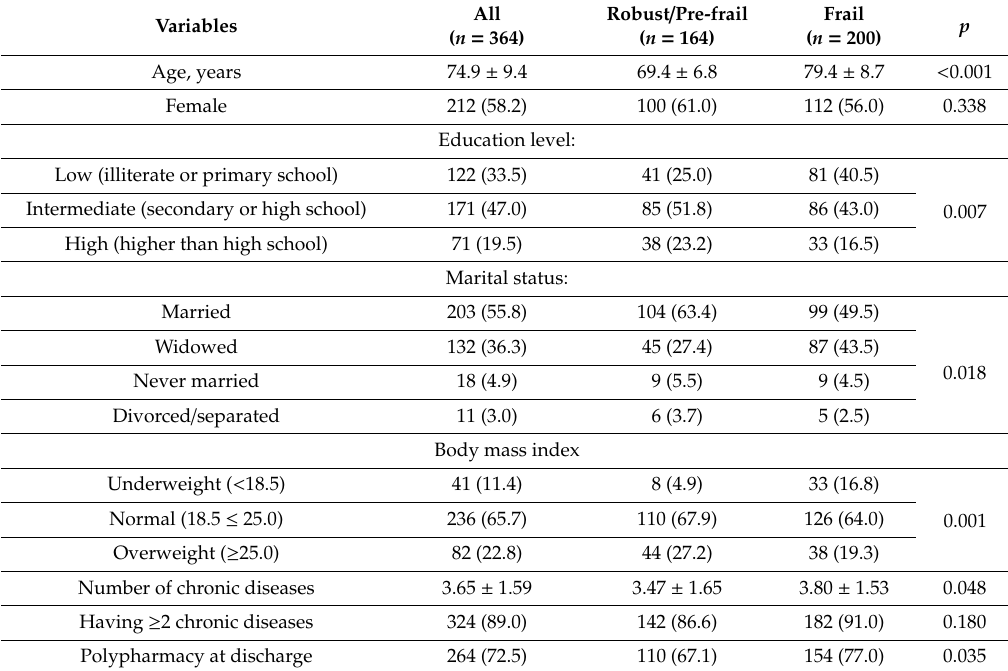
Figure 1. Distribution of the Clinical Frailty Scale categories. Table 1. General characteristics by frailty status.